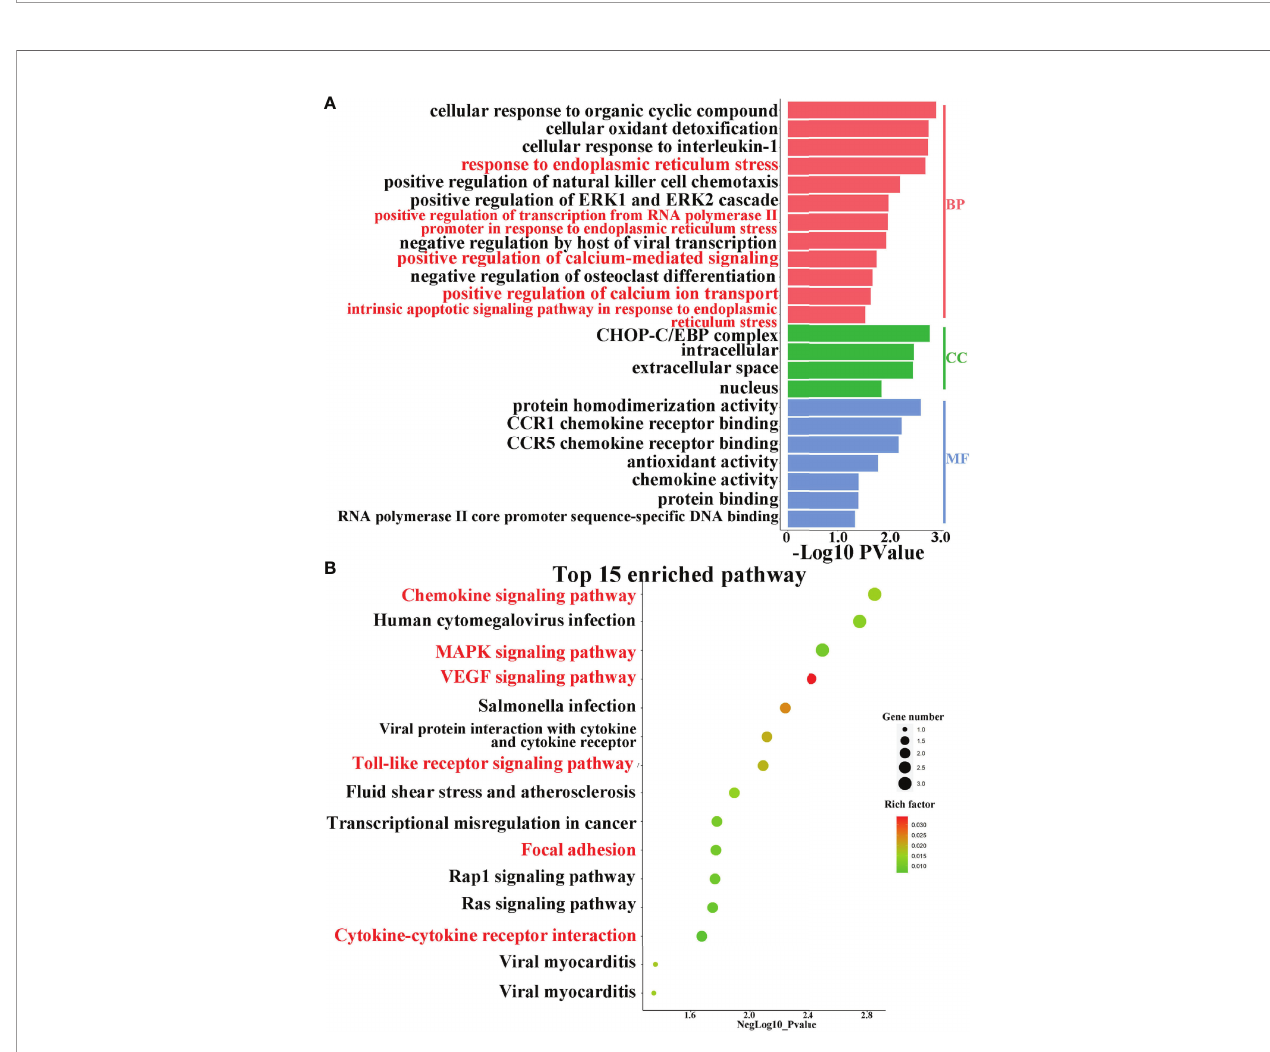
FIGURE 4 | Pathway enrichment analysis. (A) GO enrichment analysis of intersection genes. GO analysis divided gens into three functional groups: molecular function (MF), biological processes (BP), and cell composition (CC). (B) Dot plot of KEGG enrichment analysis. The abscissa indicates the -Log10_Pvalue, the ordinate indicates the names of the pathways. The size of the dot indicates the number of enriched genes, and the different colors indicate the rich